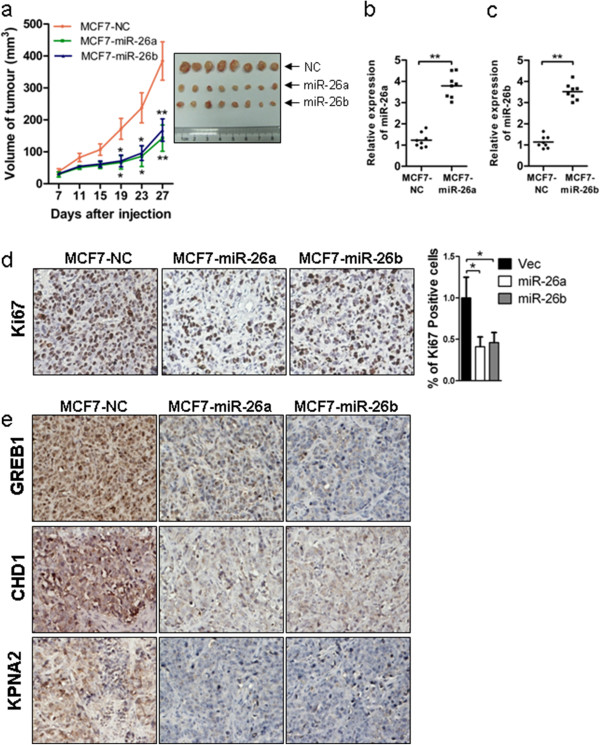
miR-26 inhibits breast tumor growth in vivo. (a) MCF-7-NC, MCF-7-miR-26a and MCF-7-miR-26b cells mixed with matrigel were transplanted into the mammary fat pad of immunodeficient mice supplemented with 17β-estradiol (E2), and tumor sizes were measured every 4 days until day 27 and the tumors were harvested. (b, c) The relative expression levels of miR-26a/b between tumors derived from MCF-7-NC and tumors generated from MCF-7-miR-26a respectively were quantified by TaqMan stem-loop quantitative real-time polymerase chain reaction. U6 was used as an internal control. (d) Tumors derived from MCF-7-miR-26a/b cells showed a lower level of Ki-67 protein than tumors derived from MCF-7-NC cells. (e) Immunohistochemistry analysis of GREB1, CHD1 and KPNA2 expression for tumor sections. *P < 0.05. **P < 0.01.